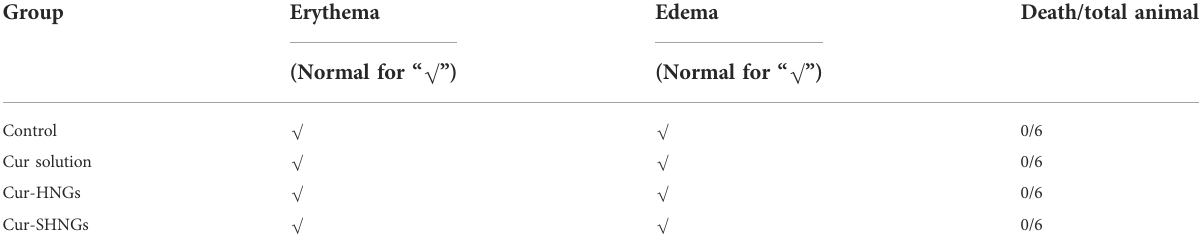
TABLE 1 Appearance of mice belonging to the physiological saline (control) group and to the groups treated with Cur solution, Cur-HNGs, and Cur- SHNGs. Experiments were completed on six animals for each group. Group